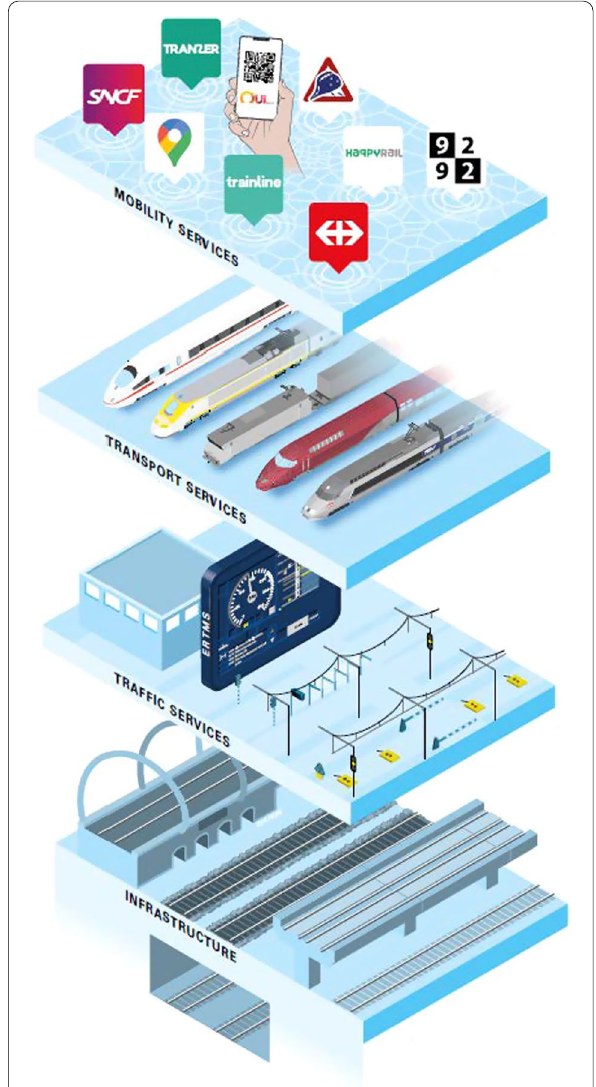
Fig. 1 The four layers of the international rail transport